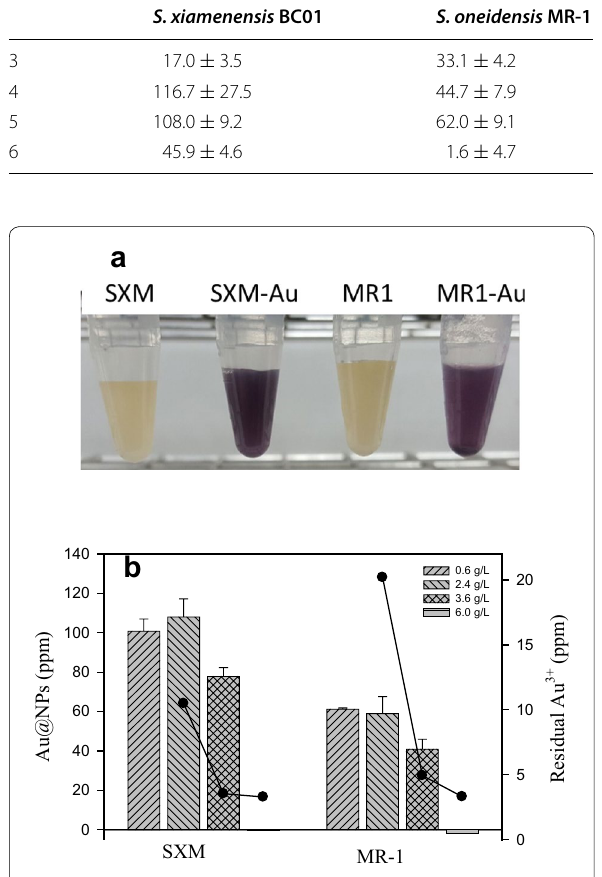
Fig. 1 a The image of Au@NP production by SXM and MR‑1. b The effect of Shewanella biomass on Au@NP formation when immersed in 300 ppm Au 3 + after 24 h. Left axis, bar: Au@NPs. Right axis, dot: residual Au 3 +